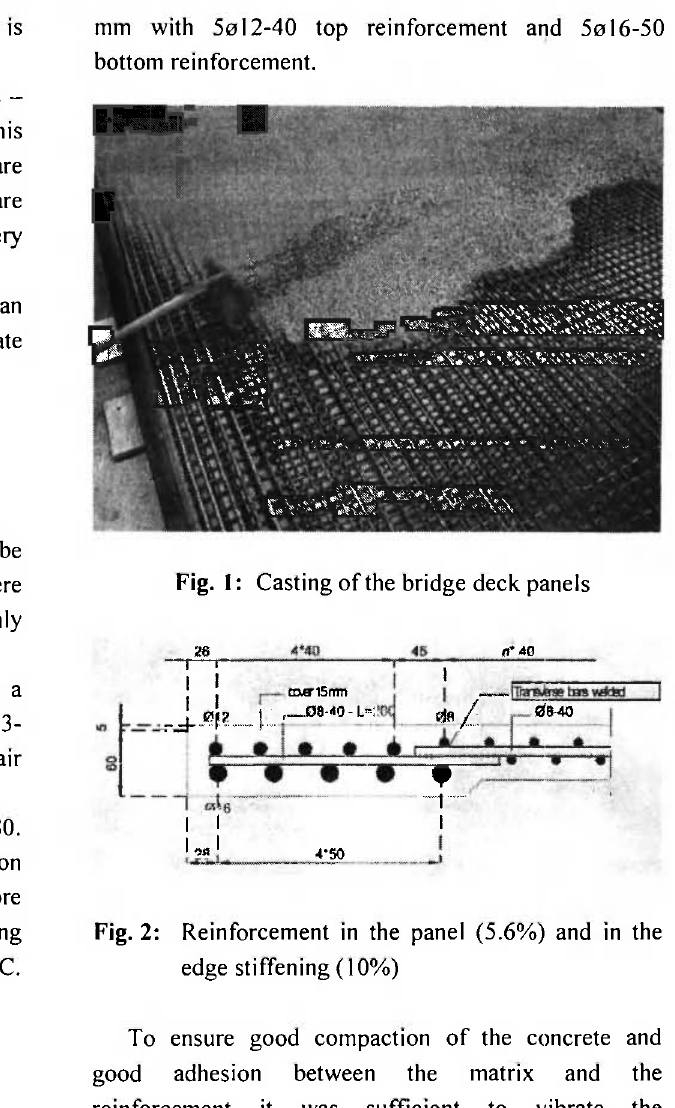
Fig. 2: Reinforcement in the panel (5.6%) and in the edge stiffening (10%) To ensure good compaction of the concrete and good adhesion between the matrix and the reinforcement was to vibrate the mould for half a